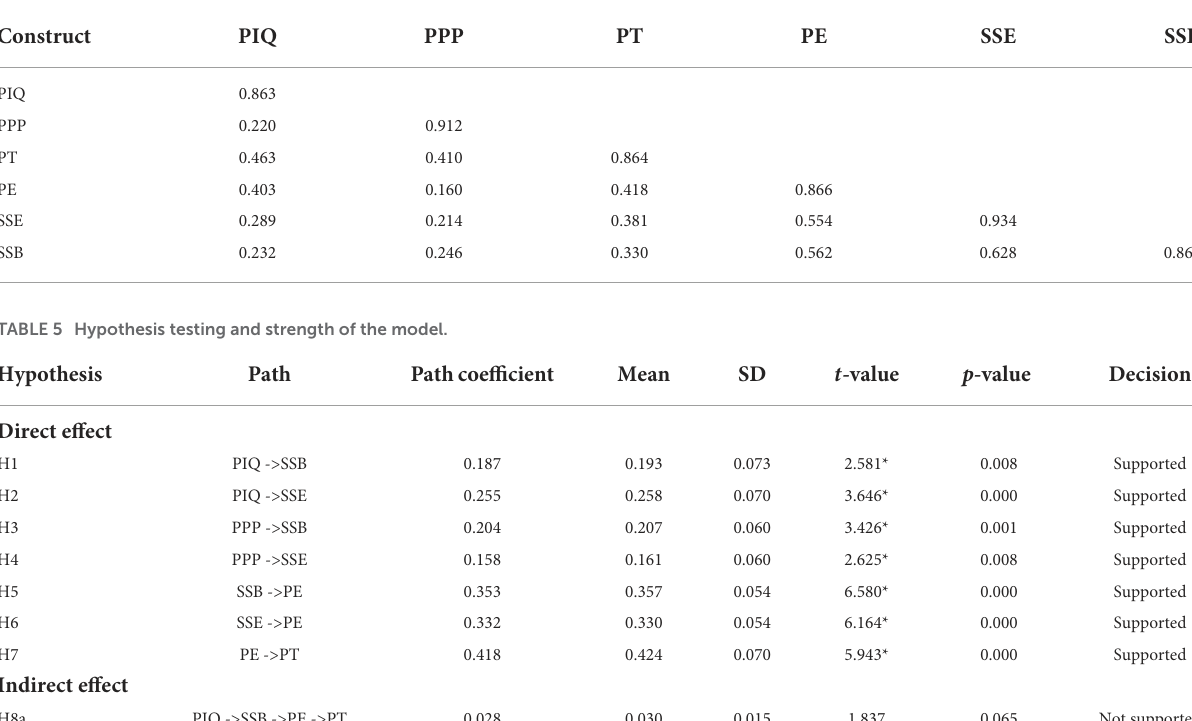
TABLE 4 Analysis of discriminant validity.